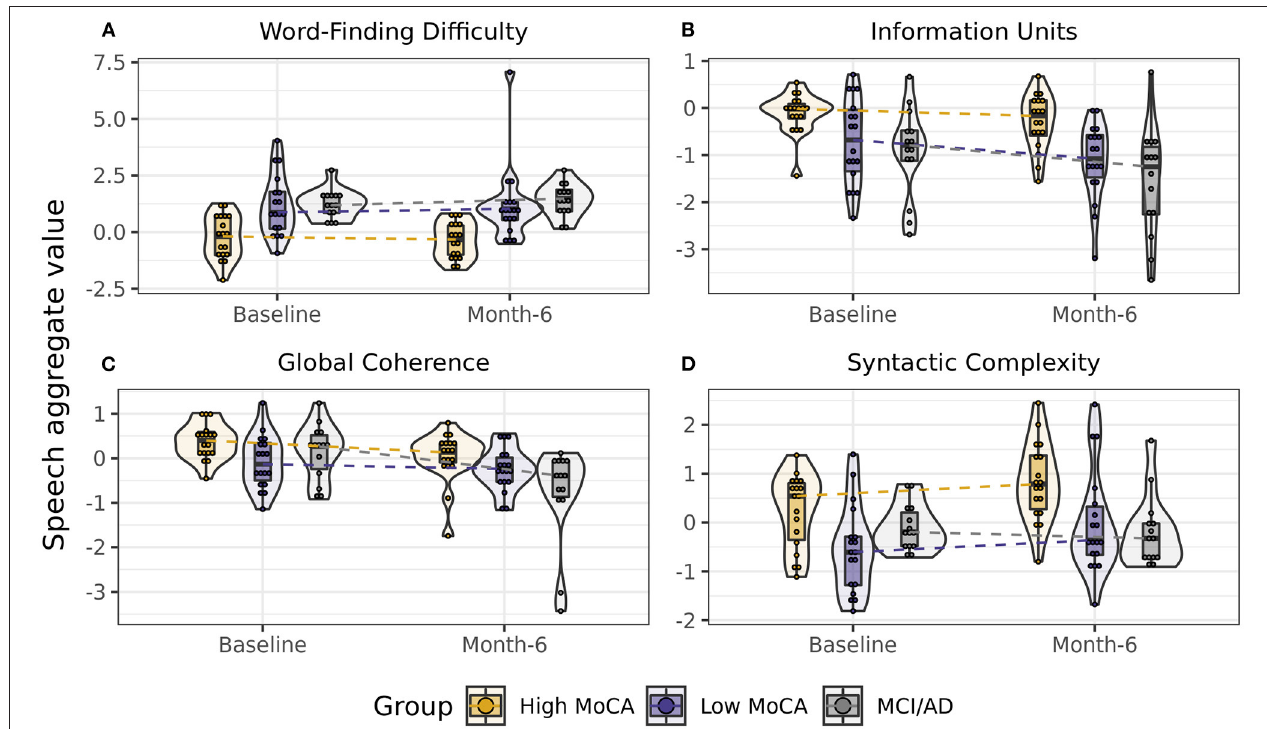
FIGURE 2 | Scores on speech aggregates that showed significant differences between groups. (A) Word-finding difficulty scores, reflecting increased pauses, and slower speech, were highest in the MCI/AD group and lowest in the High MoCA group. (B) Information units scores, reflecting how much content was accurately described in the pictures, were highest in the High MoCA group and lowest in the MCI/AD group. (C) Global coherence scores, reflecting the semantic relatedness of descriptions to the key words in the picture, were highest in the High MoCA group and had the greatest decline over 6-months in the MCI/AD group. (D) Syntactic complexity scores, reflecting the complexity of the sentences used, were highest in the High MoCA